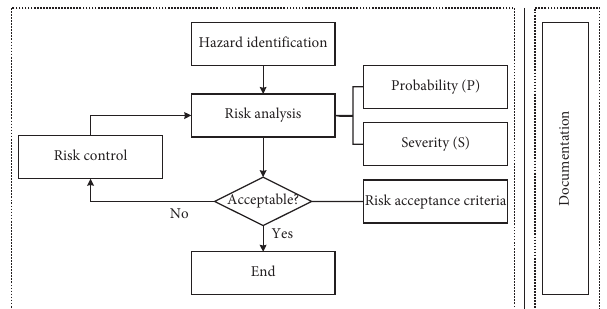
Figure 1: General process of safety